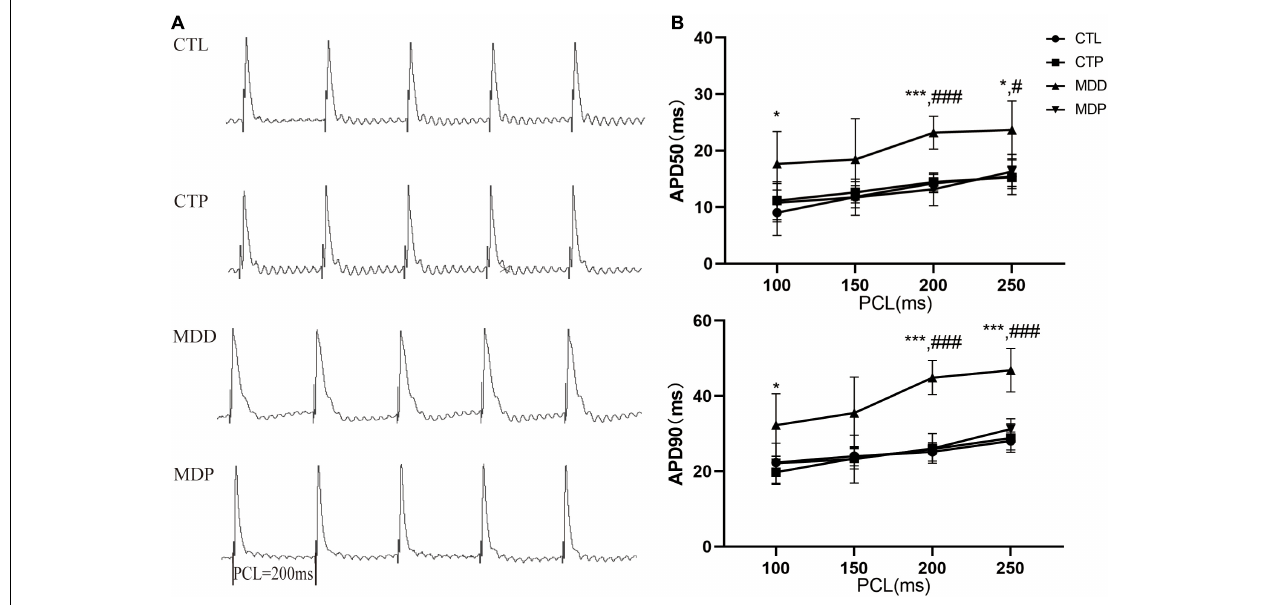
FIGURE 3 | Action potential duration. (A) Typical recordings of APD at a PCL of 200 ms. (B) The spatial dispersions of APD 50 and APD 90 . n = 8 per group. * p < 0.05, *** p < 0.001 vs. CTL; # p < 0.05, ### p < 0.001 vs. MDD.